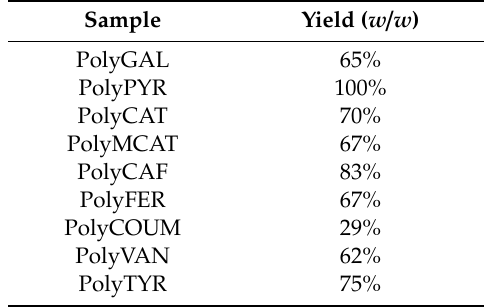
Table 1. Recovered yields of acid-treated phenolic polymers 1 .